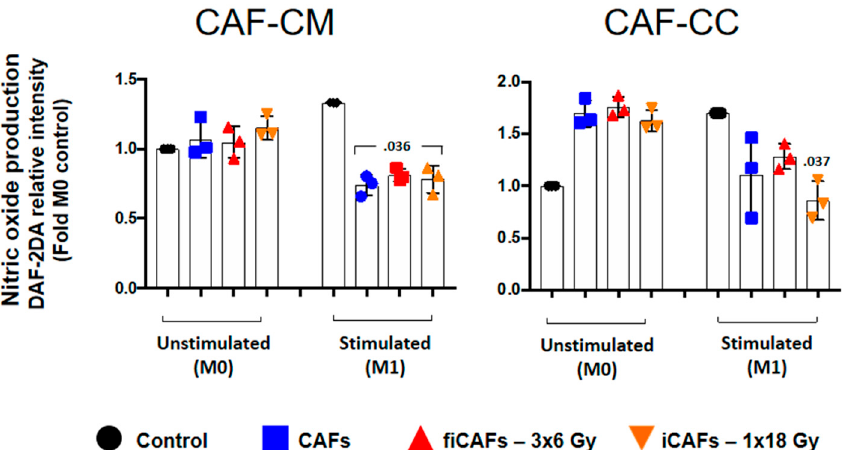
Figure 5. CAF-induced nitric oxide production by macrophages. Monocyte-derived macrophages in non-stimulated or stimulated conditions were incubated with irradiated or non-irradiated CAF-conditioned medium (CM) or in co-culture (CC), followed by analysis of expression levels of nitric oxide by macrophages, measured by DAF-2DA fluorescence assay. Black filled circles indicate expression levels in control macrophage cultures (M0 and M1). Results are expressed as fold M0-controls. Data represent the mean ( ± SD) values from 3 di ff erent CAF donors measured independently. Non-parametric Kruskal-Wallis test and p -values were determined between control and non-irradiated CAFs, control and (fractionated) irradiated CAFs individually.